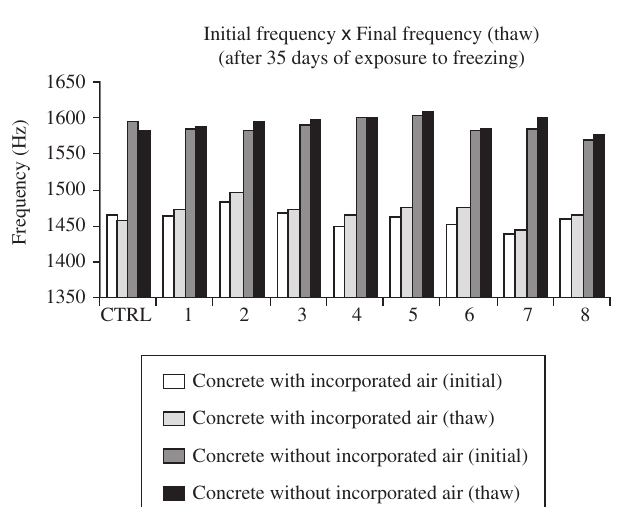
Figure 11. Natural frequency after the period of 35 days of exposure to freezing. Source: Lima 9